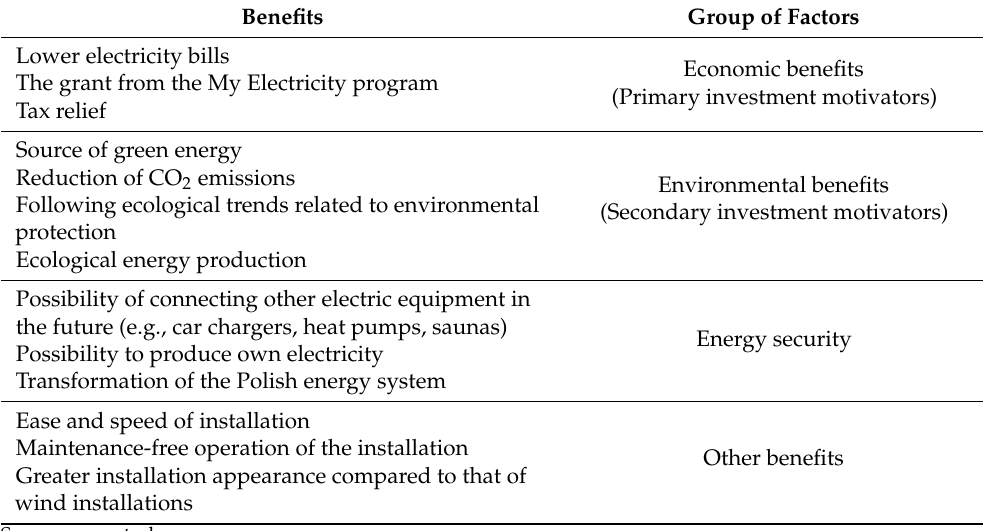
Table 2. Benefits of a PV micro-installation ( n = 12). Benefits Group of